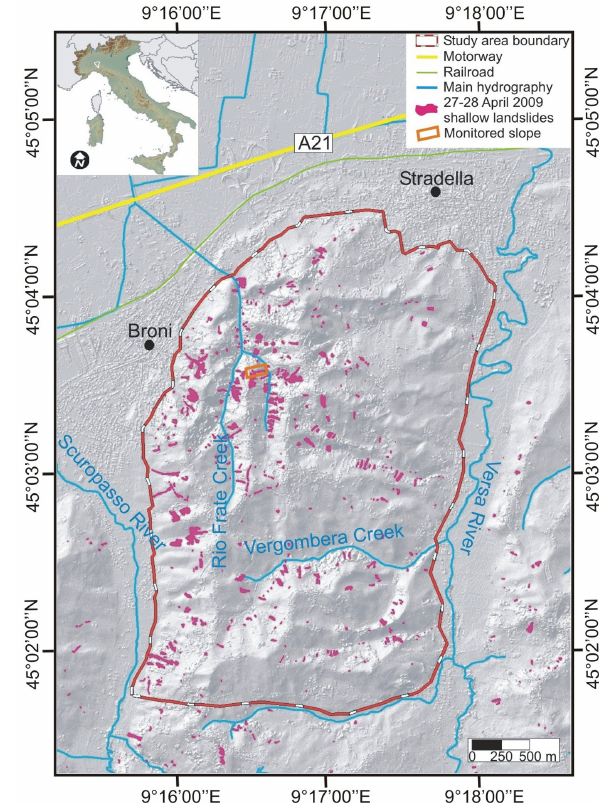
Figure 1. Location of the study